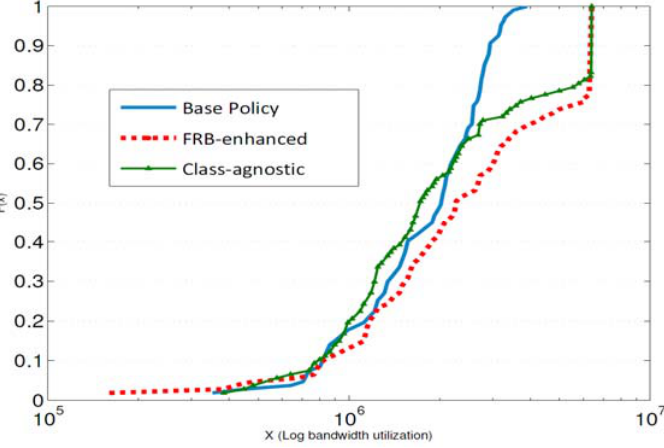
Figure 17. Cumulative Distribution Functions of total bandwidth utilization for ρ =